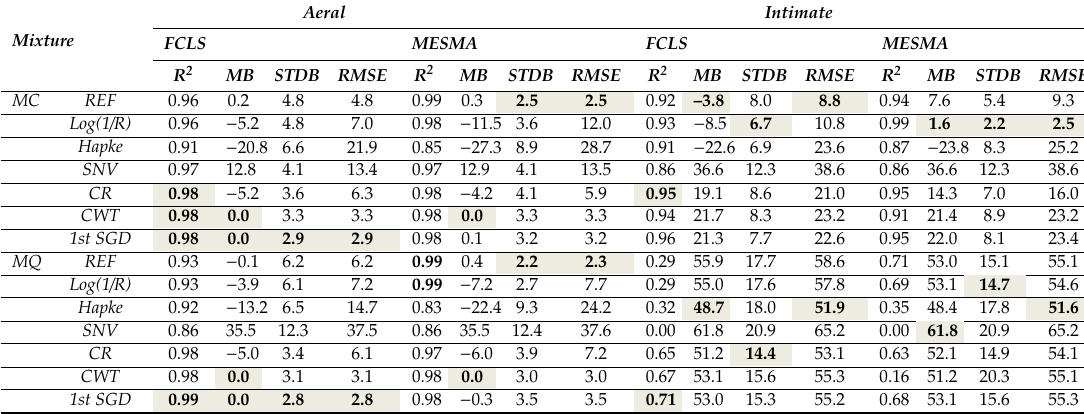
Table 6. Performances of linear unmixing methods to estimate montmorillonite abundances for MC and MQ aeral and intimate mixtures with di ff erent combinations of spectral preprocessings (best results in grey cells with bold